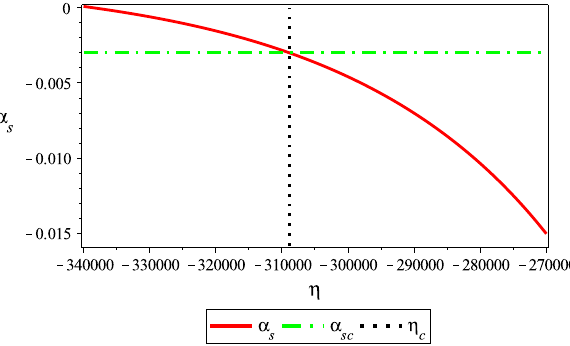
Fig. 4 The behavior of α s around the crossing time (solid line) which it is equal to α sc at η